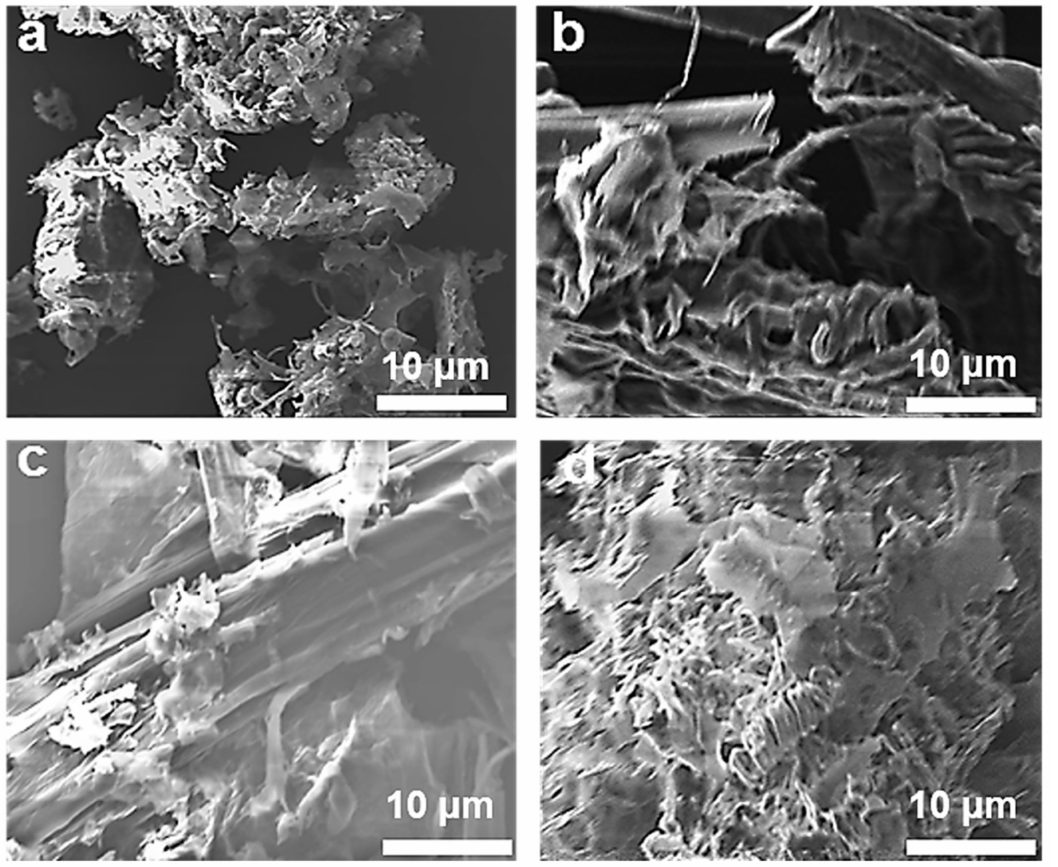
Figure 5. SEM micrographs of biomass materials: ( a ) RBS, ( b ) BST2, ( c ) RPS, and ( d ) PST2. Scale bar: 10 µ